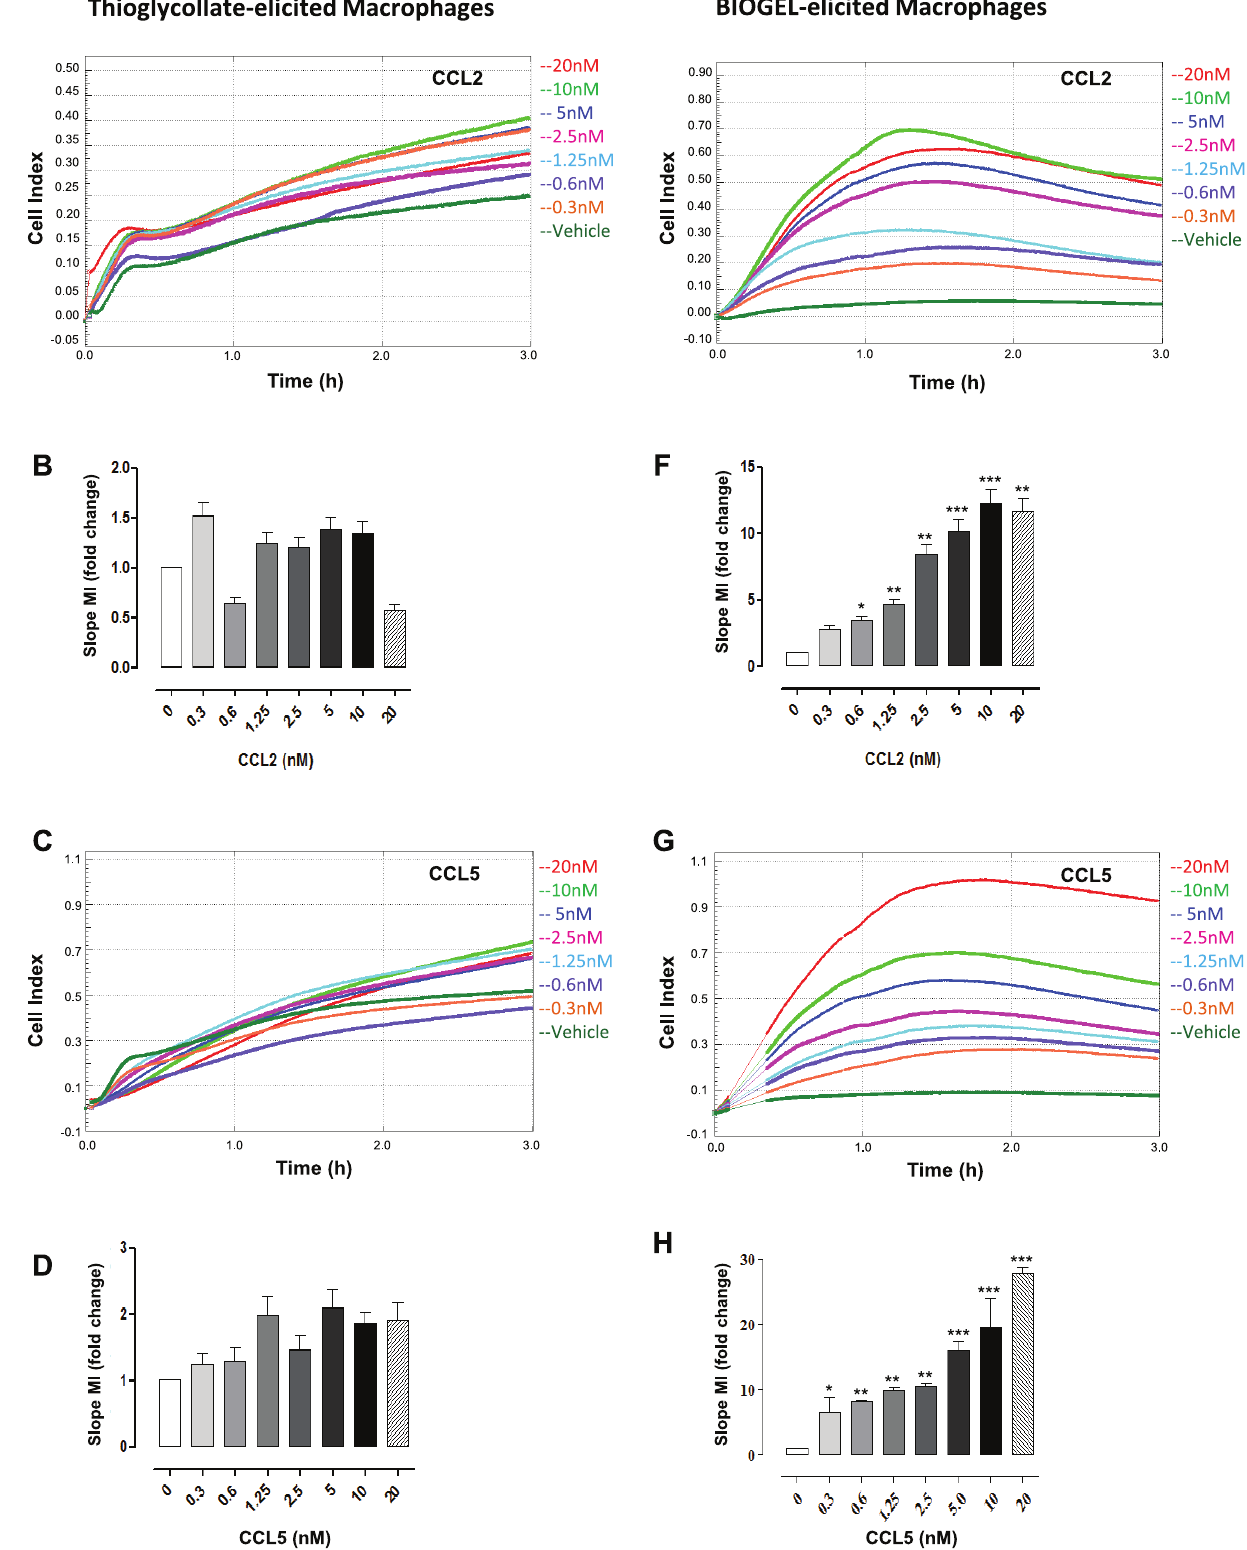
Figure 3. Bio-Gel and thiogclycollate elicited macrophage chemotaxis to CCL2 and CCL5. Thioglycollate and Bio-Gel elicited macrophages (4 6 10 5 total) were allowed to migrate toward indicated concentrations of murine CCL2 ( A & E ) and CCL5 ( C & G ) for 4 h. Migration was measured for each curve of each concentration using slope analysis ( B & F- D & H ). Data are shown as migration index (i.e. fold change over